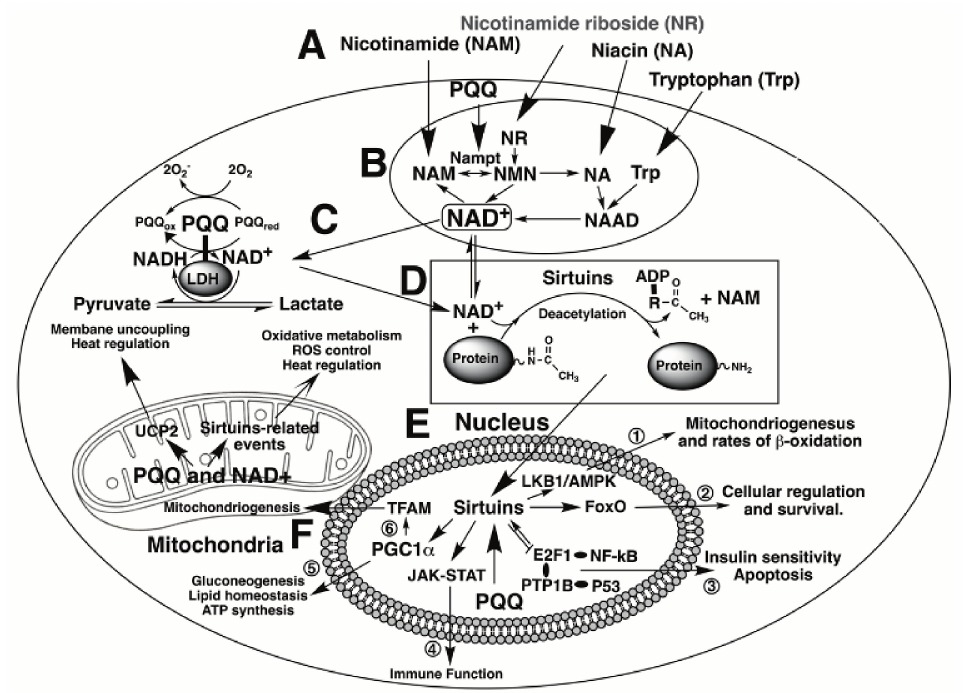
Figure 2. PQQ and cellular NAD + . Events elicited by PQQ and NAD+ are highlighted. At the top of the figure, A , niacin-related serum components are depicted that are important in the production of NAD+. Each interacts to generate NAD+ as indicated in the section encircled as B . PQQ plays a role in the process by enhancing the expression of nicotinamide phosphoribosyltransferase (designated as Nampt}. Increasing Nampt activity increases NAD+ cellular levels. NAD+ performs two principal functions; first, as a cofactor for dehydrogenases and reductases, such as lactic acid dehydrogenase (LDH), C, and second, as a co-substrate for sirtuin-catalyzed protein deacetylations as noted in D . Likewise, PQQ is a catalytic cofactor for LDH, C. PQQ facilitates the conversion of lactate to pyruvate. In the nucleus, E , NAD+, as a co-substrate for sirtuins, promotes targeted acetylation or deacetylation of proteins involved in cell signaling. Six examples are enumerated: (1) the